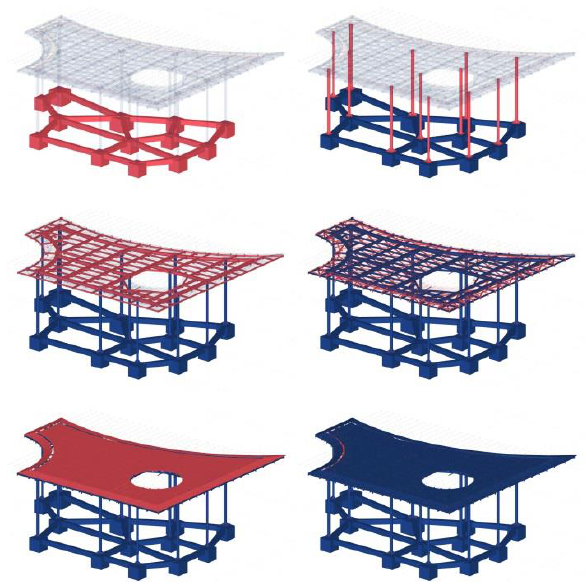
Figure 12. Building phases in Tekla